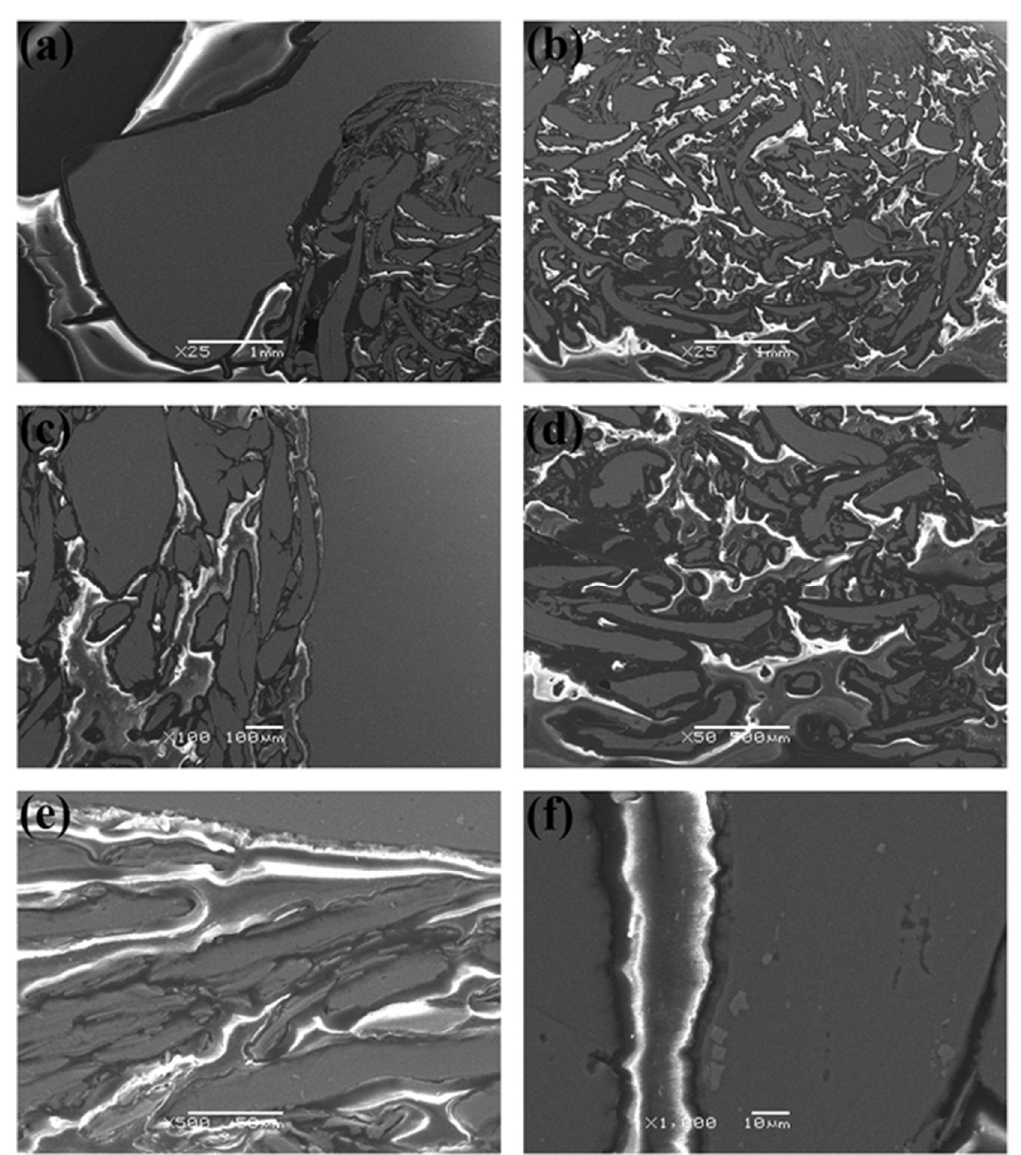
Figure 3. SEM images for the aluminum-polymer interfaces in the intermixed regions of the stir zone; where bright gray contrast is Aluminum layers, dark gray matrix is melted and re-solidified polymer, dark spots through polymer matrix are shrinkage voids, and mixed gray–white contrast at interface presents the solid state modified polymer via FSW. Reprinted with permission from Ref. [73]. 2014, F. Khodabakhshi et al.